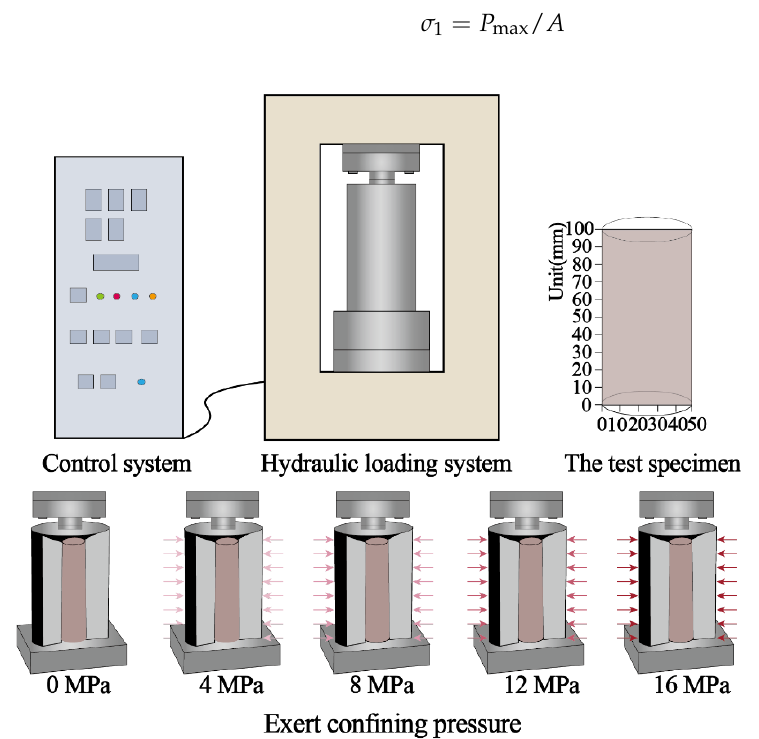
Figure 9. Triaxial experimental equipment.